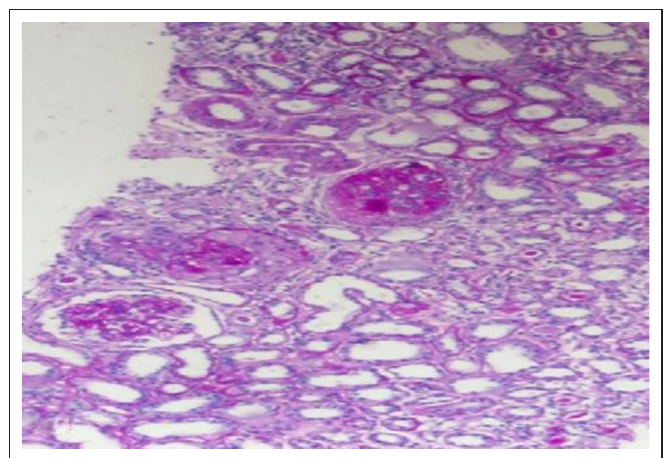
Figure 2. Pathological findings of the renal biopsy. Light microscopy showing 3 glomeruli with a cellular crescent. The tubulointerstitial compartment shows interstitial inflammation and acute tubular injury. (PAS stain, magnification 10 × ). PAS, periodic